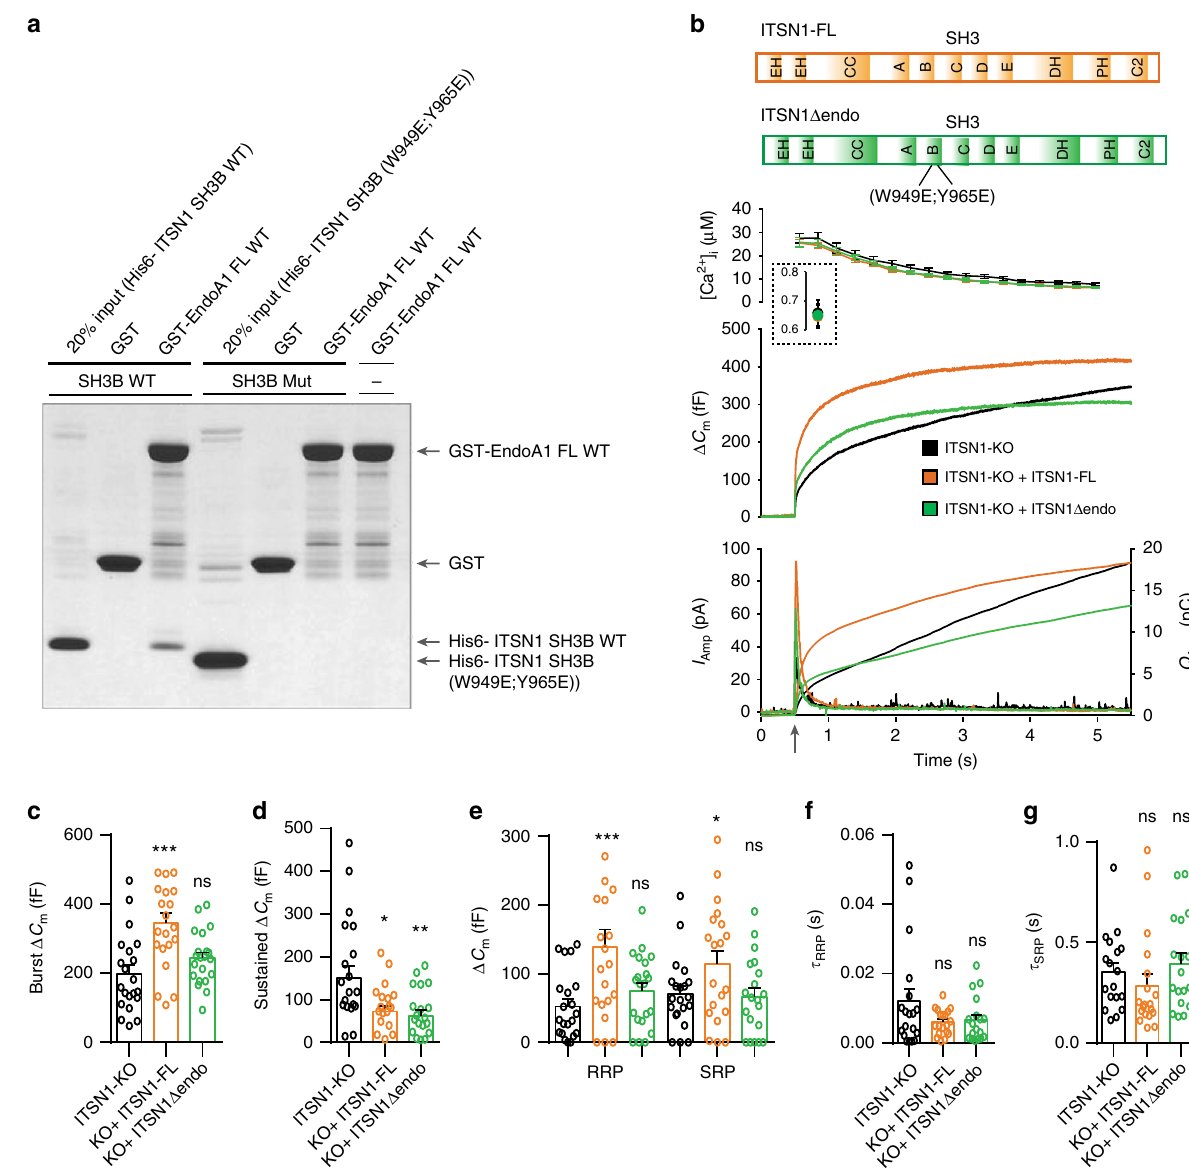
Fig. 8 Intersectin ’ s role in exocytosis is mediated through its interaction with endophilin. a Pull-down experiment revealed an interaction between the SH3 domains of endophilin 1 and ITSN-1 that was perturbed when recombinant ITSN-1 with two-point mutations (W949 + Y965E) was used. Representative blot (three independent experiments were performed). b Exocytosis measured in ITSN1 KO cells (black traces) and ITSN1 KO cells expressing full-length proteins ITSN1 WT (orange traces) or ITSN1 Δ endo (W949 + Y965E in the SH3 domain, indicated in the schematic) (green traces). Panels are arranged similar to Fig. 1i. Note that ITSN1 KO cells expressing ITSN1 W949 + Y965E did not on average differ from ITSN1 KO cells (except for the sustained release), while expression of full-length ITSN1 WT was signi fi cantly higher. c – g Exponential fi tting analysis revealed that burst ( c ), as well as the vesicle pool sizes ( e ), and kinetics ( f , g ), could be rescued by expression of ITSN1 WT, but no ITSN1 W949 + Y965E (sustained release could not be rescued). b – g N = 3, 3 mice each, number of analyzed cells: ITSN1-KO (18 cells), ITSN1-KO + ITSN-FL (19 cells), and ITSN1-KO + ITSN- Δ endo (18 cells). Error bars denote SEM. N = number of independent replicates. One-way ANOVA with Tukey ’ s post-hoc test * p < 0.05; ** p < 0.01; *** p < 0.001, ns not signi fi